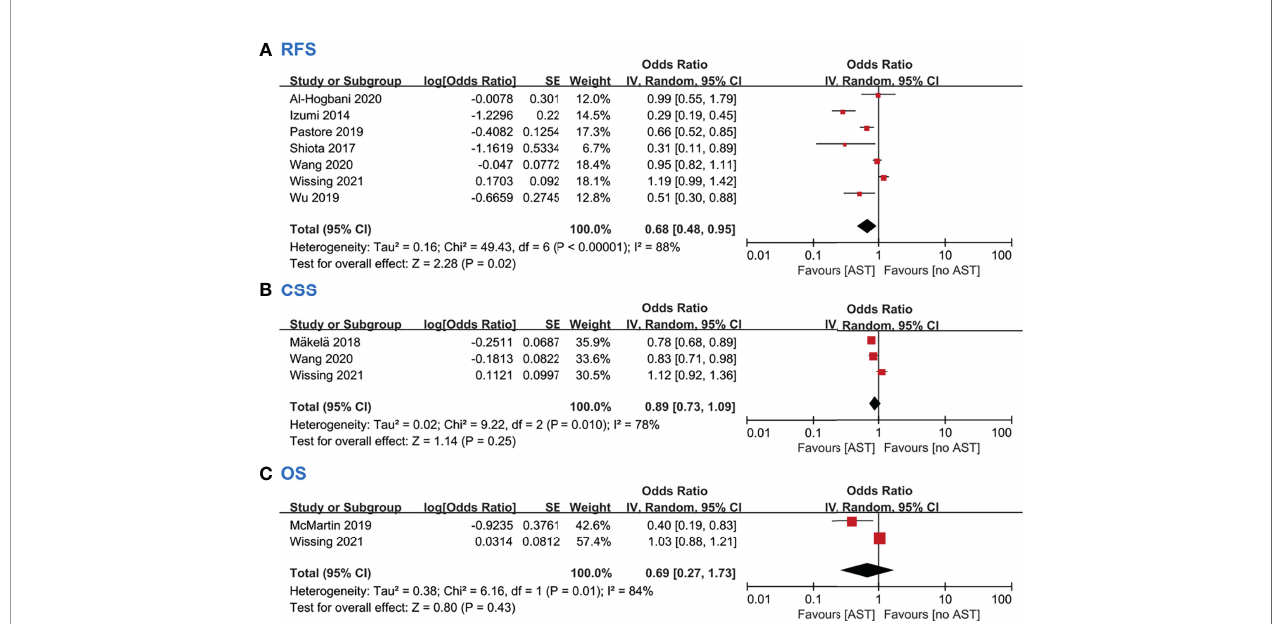
FIGURE 3 | (A) Forest plots showing the effect of AST on RFS in bladder cancer. (B) Forest plots showing the effect of AST on CSS in bladder cancer. (C) Forest plots showing the effect of AST on OS in bladder cancer. AST, Androgen suppression therapy; RFS, Recurrence-free survival; CSS, Cancer-speci fi c survival; OS, Overall